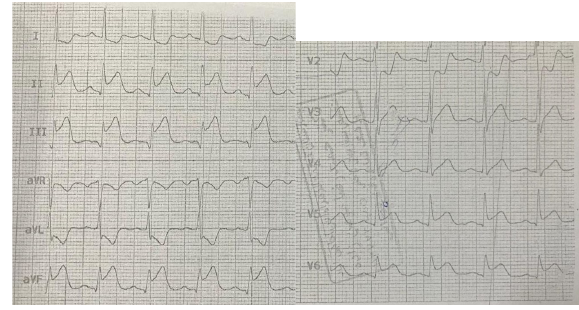
Figure 1. Patient ECG: Normal sinus rhythm, Rate:100/min, Normal Axis, St Elevation in II/III/Avf, St Depression in I and Avl and T Inversion in I and Avl.